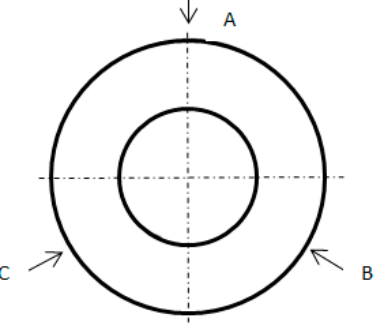
Figure 2. Locations of surface roughness and topography measurement.